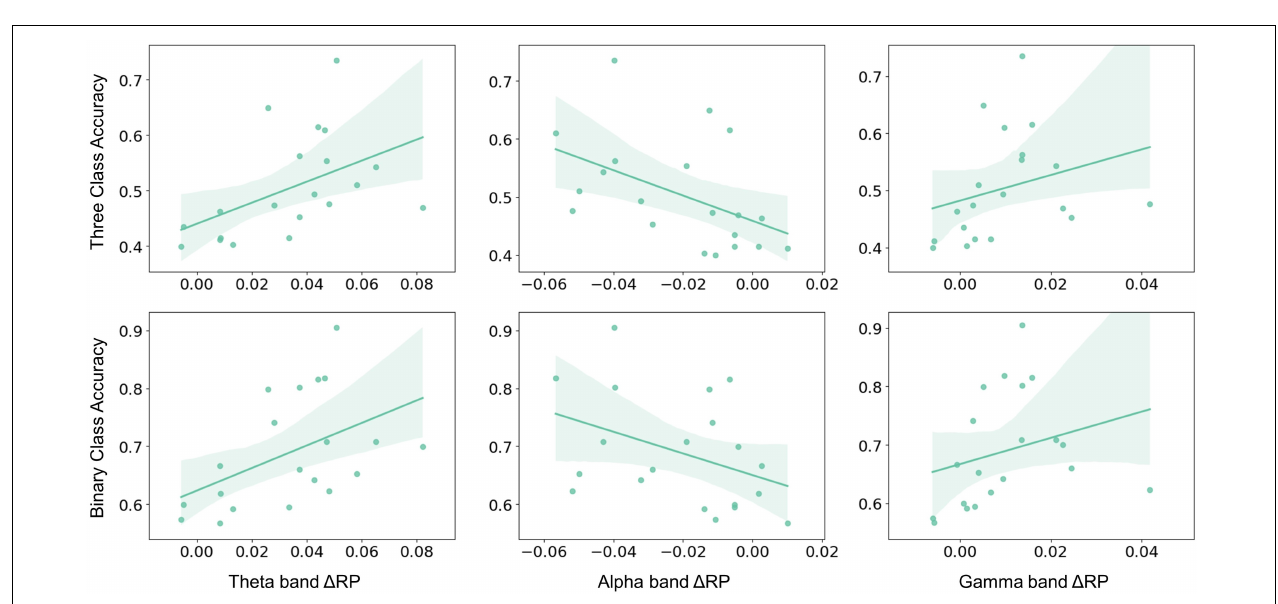
FIGURE 4 | The Spearman–rank correlation between pre-task RP and performance across subjects. Alpha band RP was positively correlated with three-class classification accuracy ( r = 0.484, p < 0.05) and binary-class classification accuracy ( r = 0.546, p < 0.05). Whereas no statistical significance was found in the correlation between theta and gamma band RP and three-class classification accuracy (theta: r = –0.376, p = 0.102; gamma: r = –0.325, p = 0.162) or binary-class classification accuracy (theta: r = –0.284, p = 0.224; gamma: r = –0.369, p = 0.109).